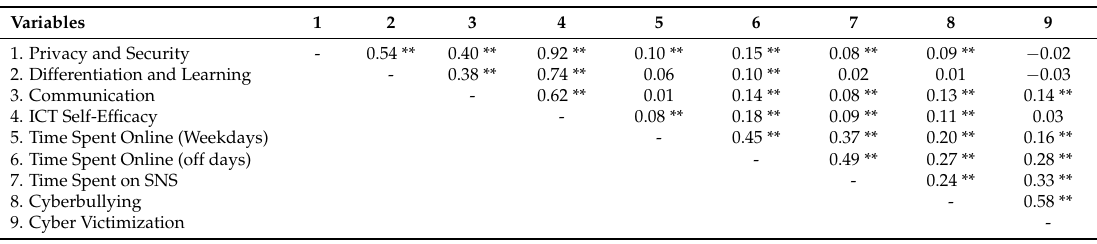
Table 4. Spearman Rho correlation between ICT Self-Efficacy, time variables, and Cyberbullying and Cyber